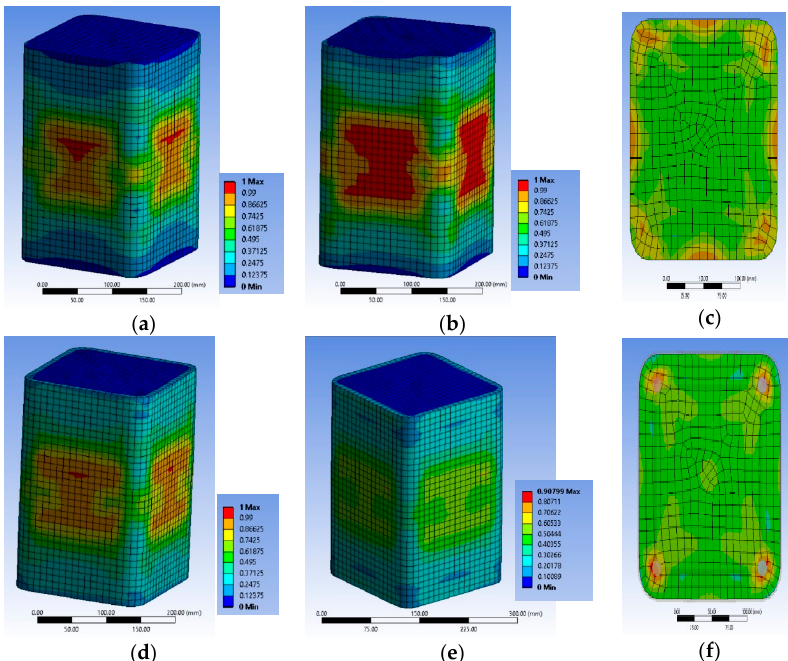
Figure 8. Variation of concrete damage of specimen BS2C1C ( a ) one step after the first concrete damage; ( b ) at the ultimate condition and ( c ) at the level of the stirrup; BS2C3C ( d ) at the ultimate condition and BS2C5C ( e ) at the ultimate condition and ( f ) at the level of the stirrup. The FE results for BS2C3C were similar with the initiation of local failure within the concrete but without simultaneous local FRP failure. However, at the ultimate condition, the damage spread